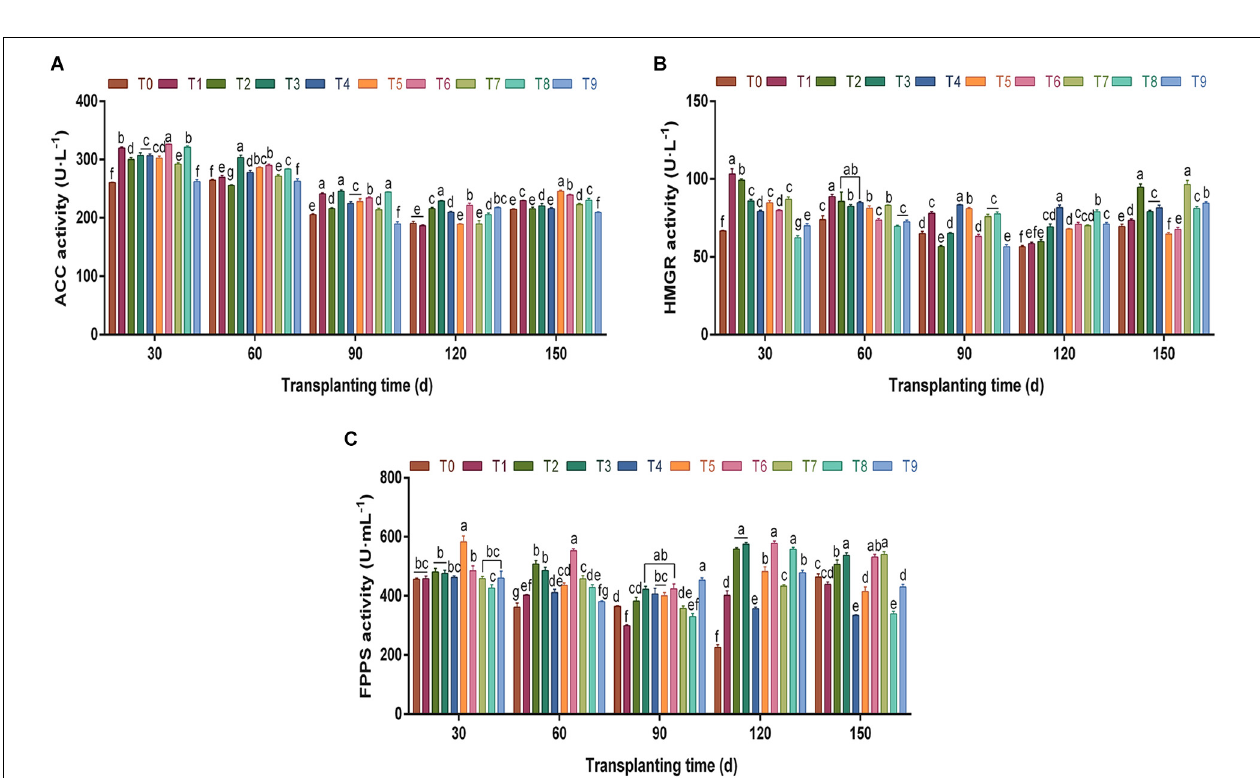
FIGURE 4 | Multi-index principal component analysis (PCA) score map of A. chinensis under different NPK combined application.